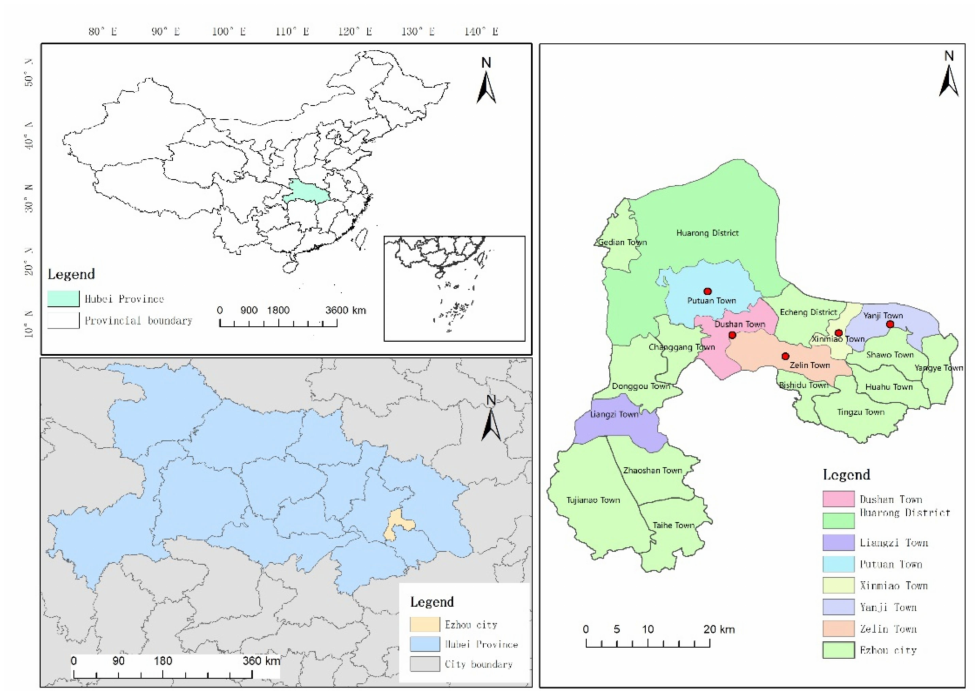
Figure 2. The location of Ezhou district, Hubei,